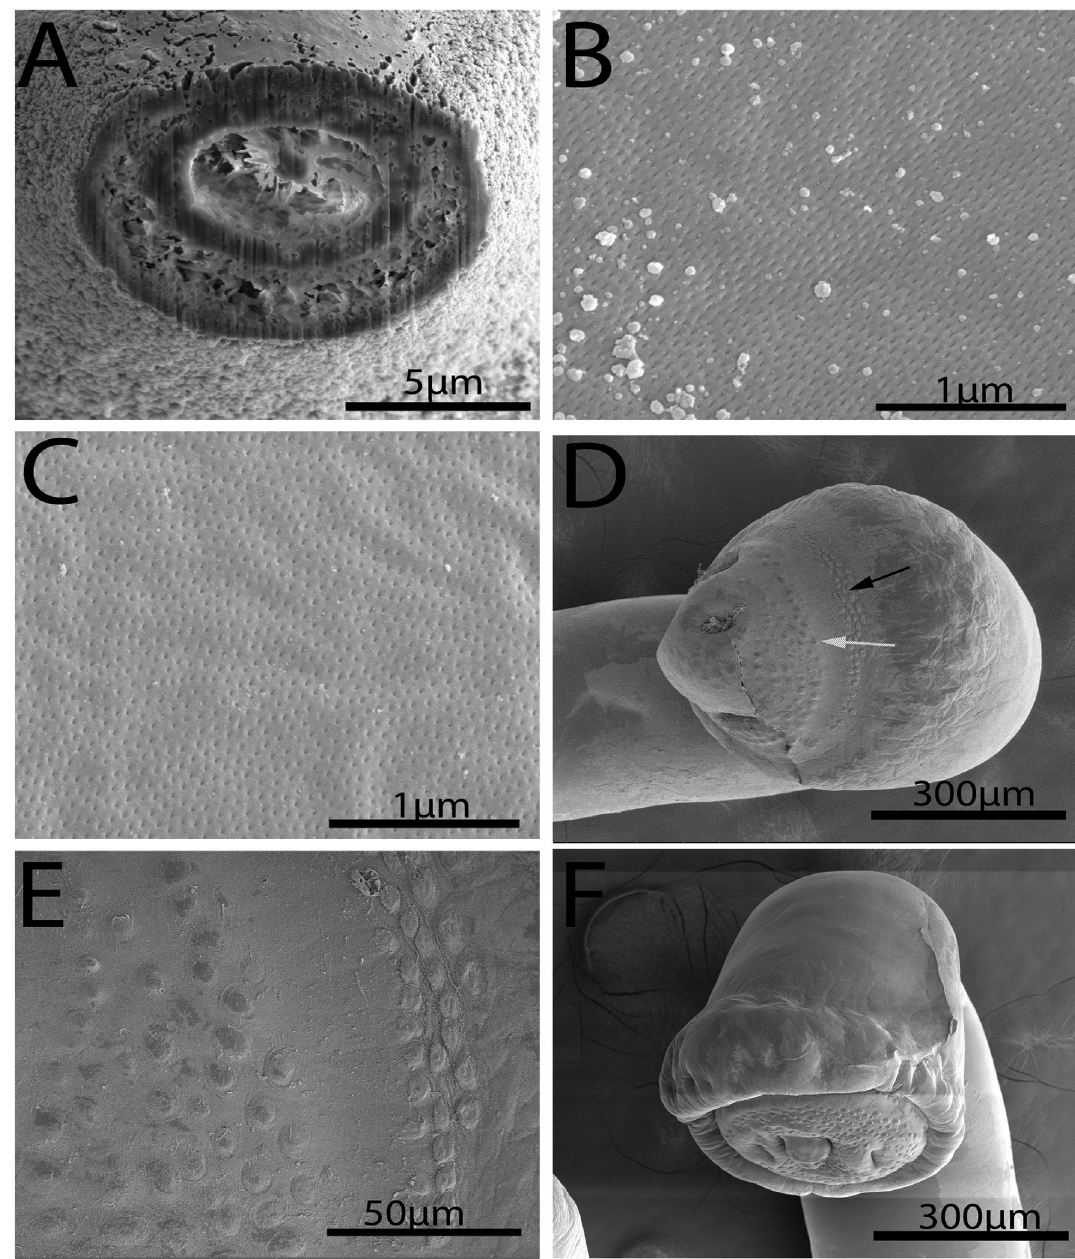
Figure 3. SEM image of specimens of Rhadinorhynchus oligospinosus from Scomber japonicus and Trachurus murphyi from off the Pacific coast of Peru. (A) A gallium cut section of a trunk spine at its base showing the differentiation between its cortical and core layers and associated spaces. (B) Micropores at the anterior part of the trunk. (C) Micropores at the Bmid-section of the trunk. Note the difference in the diameter and distribution of micropores at different trunk regions. (D) A dorsal view of the bursa showing the distribution of the outer zone (black arrow) and the inner zone (white arrow) of sensory receptors. (E) A larger magnification of sensory receptors in the outer and inner zones. (F) A ventro-dorsal perspective of a bursa showing its thick muscular margin and its terminal gonopore and